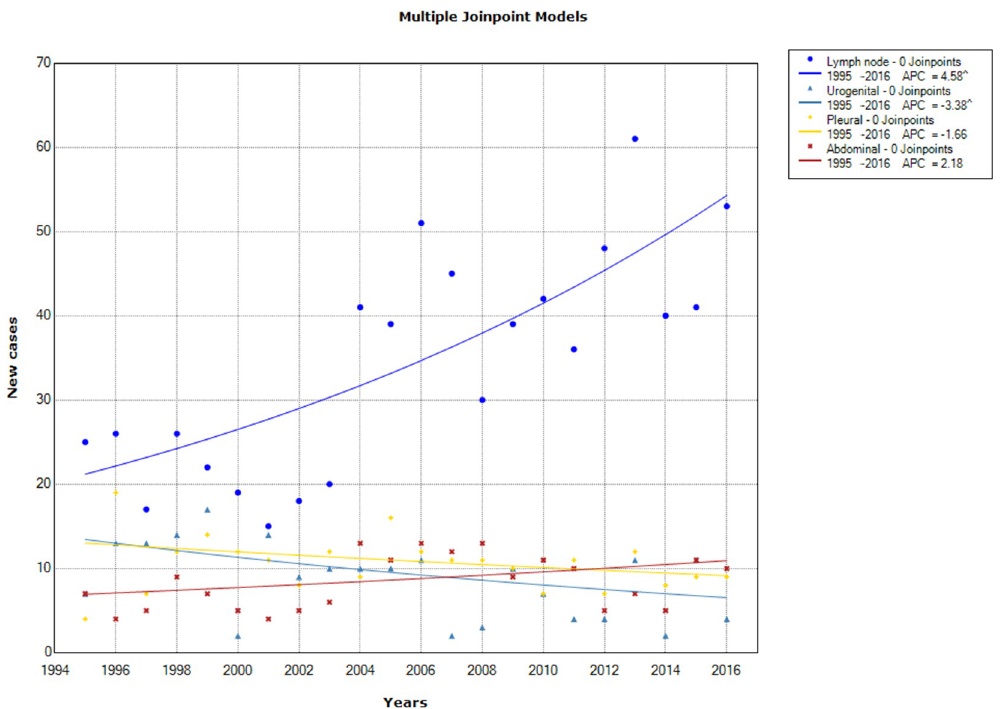
Fig 5. Chronological trends analysis of the extra-pulmonary tuberculosis annual number by form between 1995 and 2016.